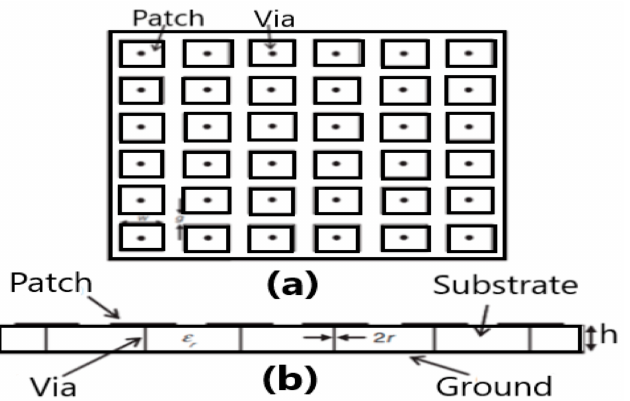
Figure 5. EBG surface: ( a ) front view, and ( b ) cross-sectional view, adapted from